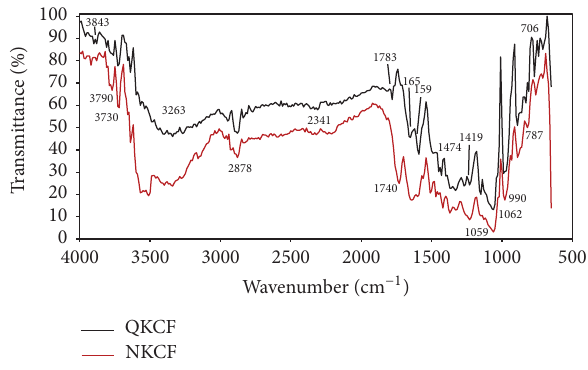
Figure 3: FT-IR spectra for NKCF and